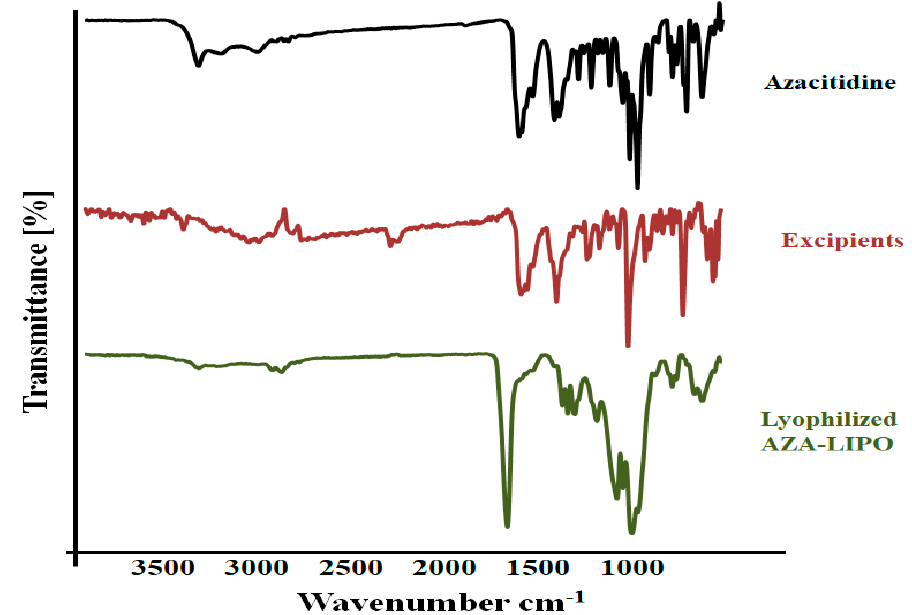
Figure 5. FTIR spectra of AZA, excipients and AZA-LIPO formulation.